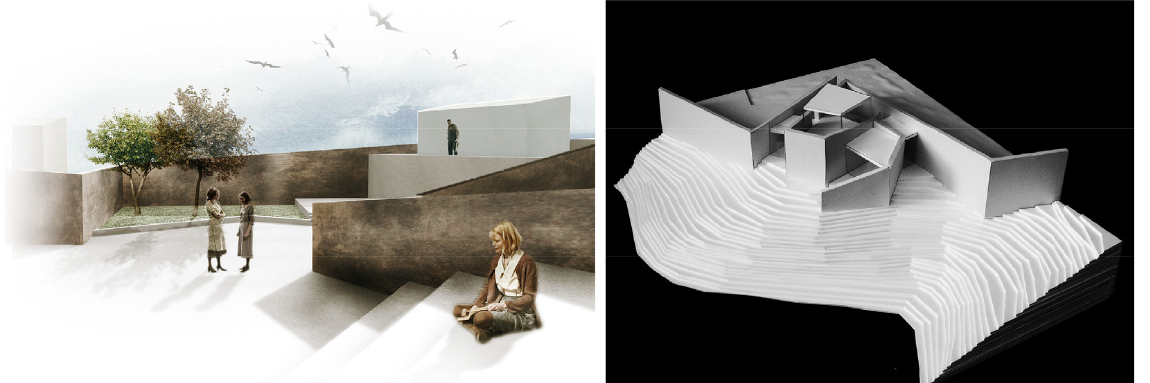
Figure 4. Dogville, inhabiting the wall. Student: Alejandro López (2013)